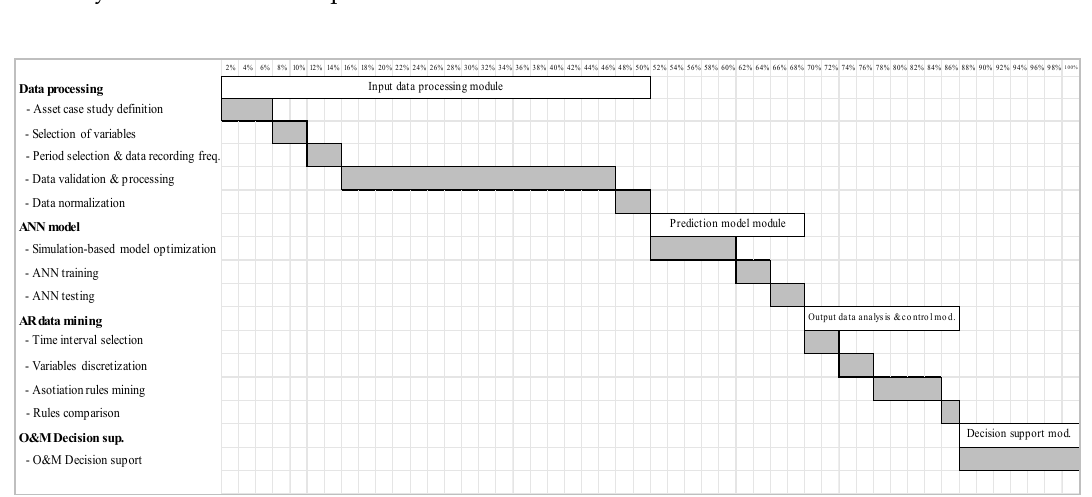
Figure 10. Project Timeline for the process implementation in the first asset (as a % of the total project make span).